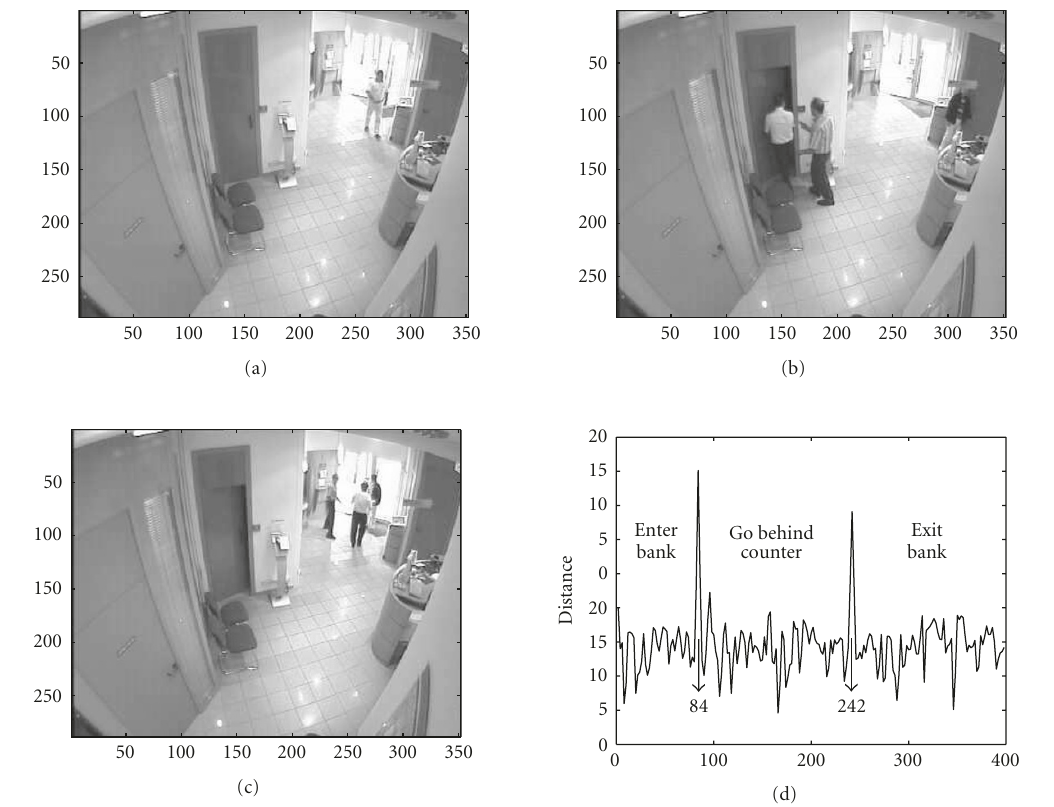
Figure 4: Bank dataset: three segments detected in the attack scenario: (a) enter bank, (b) gain access to the restricted area behind the counter, and (c) exit bank. (d) shows a plot of the switching function. Peaks in the plot indicate boundaries in temporal segmentation.